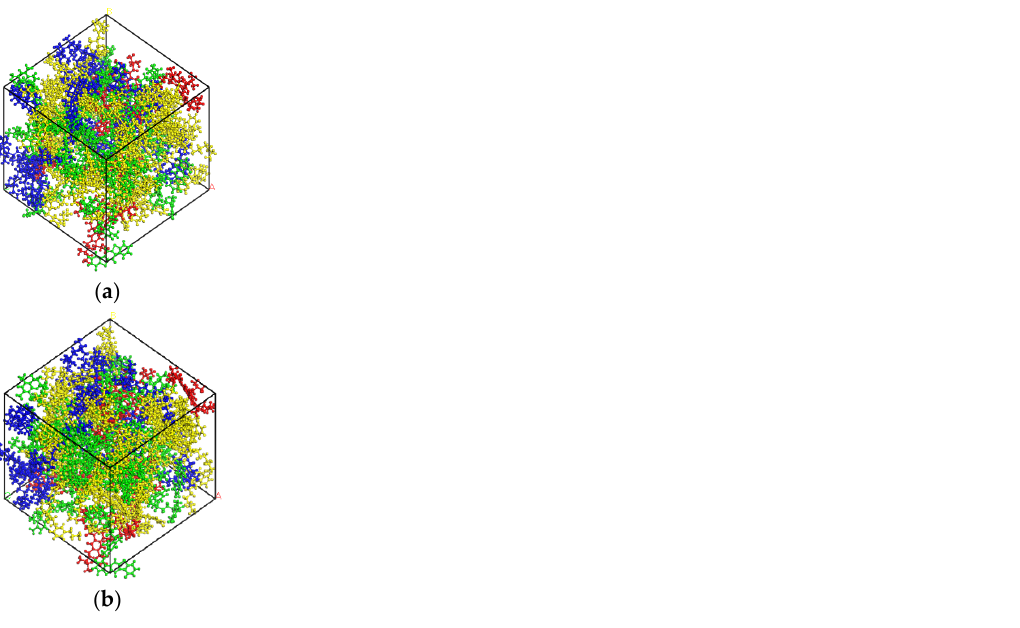
Figure 2. Molecular model of matrix asphalt before and after optimization. ( a ) Before optimization. ( b ) After optimization. Table 1. The four-component mass fraction.